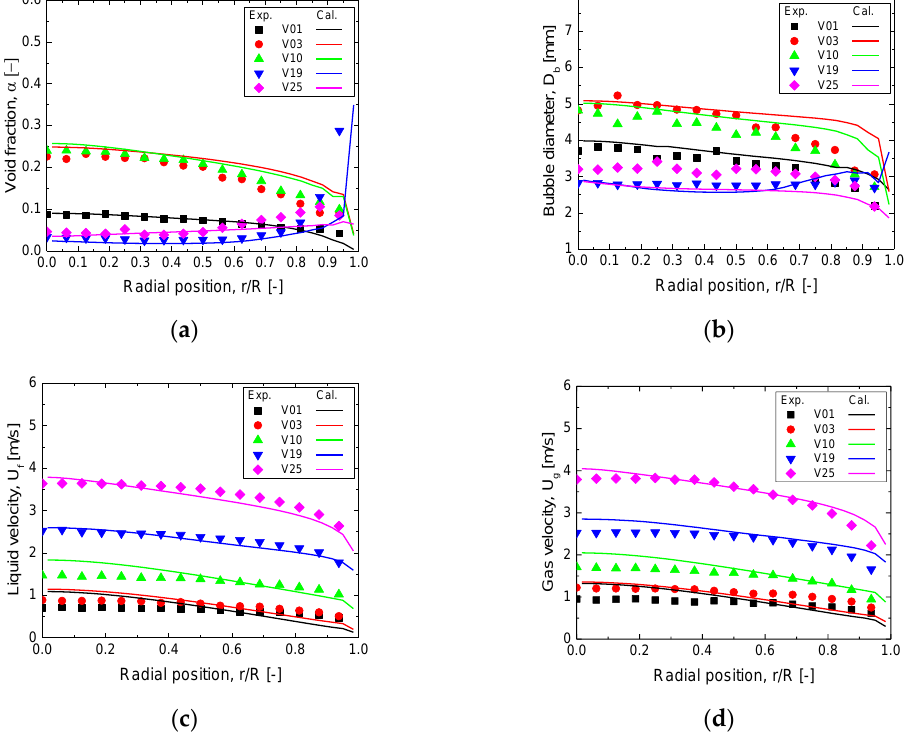
Figure 8. Comparison of the predicted two-phase parameters with the VAWL experiment: ( a ) void fraction, ( b ) bubble diameter, ( c ) liquid velocity, and ( d ) gas velocity.